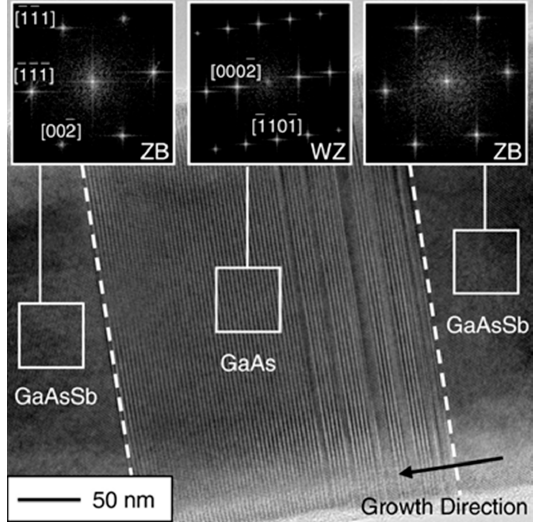
Figure 13. HRTEM image of the GaAsSb/GaAs/GaAsSb heterostructure with the zinc blend and wurtzite crystal structures. Reproduced with permission from [79], copyright AIP Publishing LLC (2010).